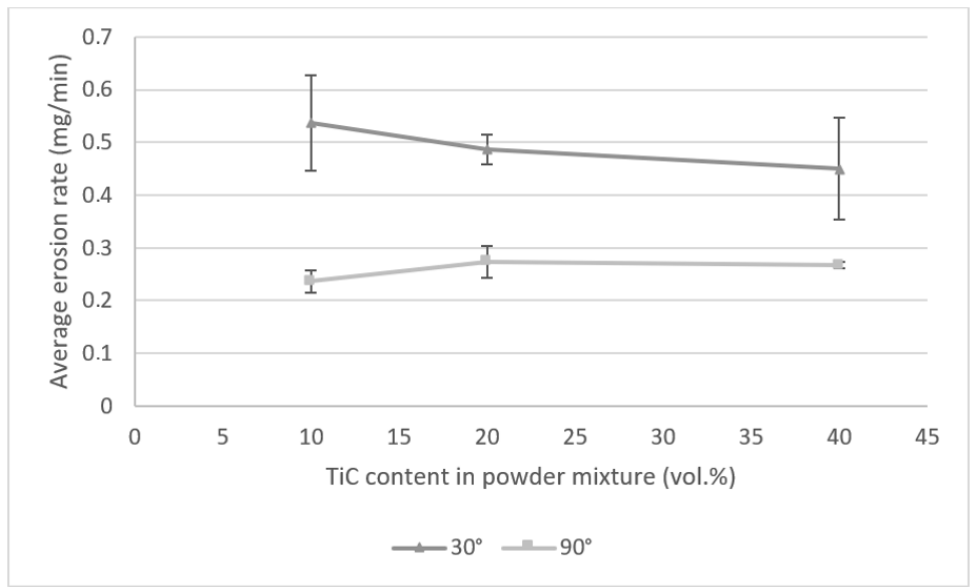
Figure 12. The effect of TiC content in the powder mixture on the average erosion rate of laser cladded composite coatings (laser beam power 2100 W, cladding speed 0.25 m/min, powder feed rate 0.04 g/mm).